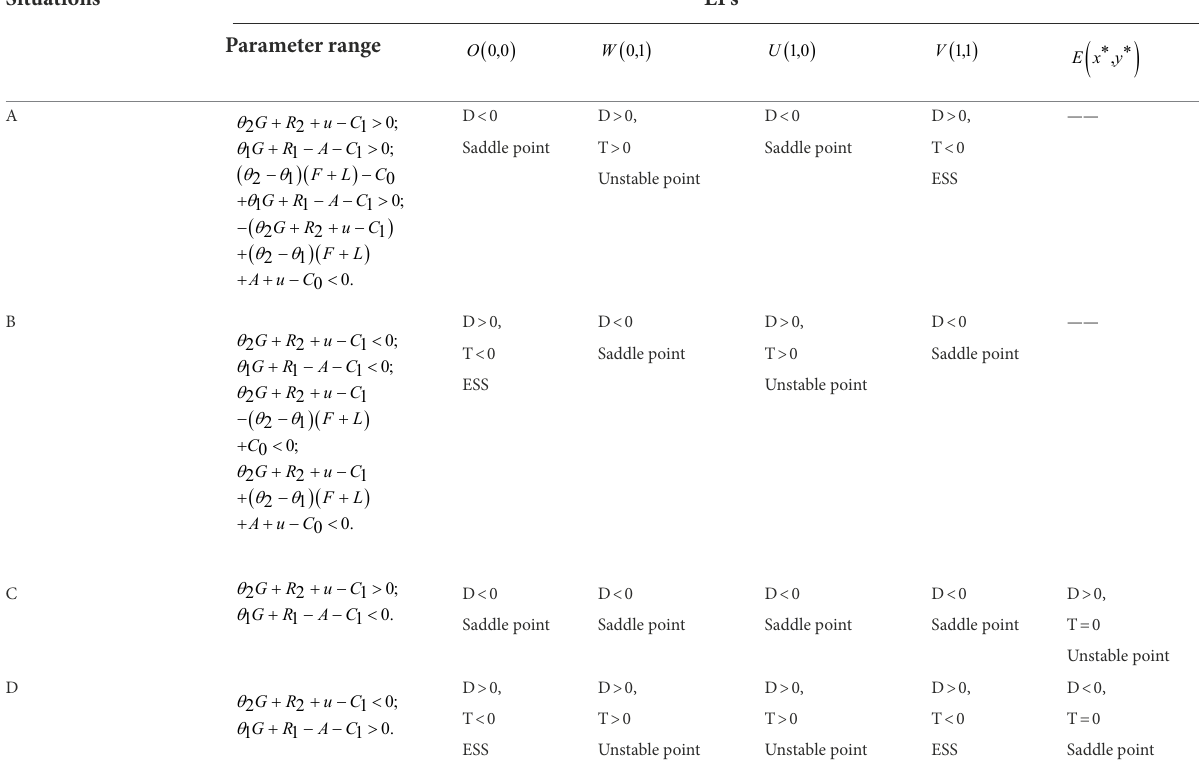
TABLE 4 Stability analysis of equilibrium points when